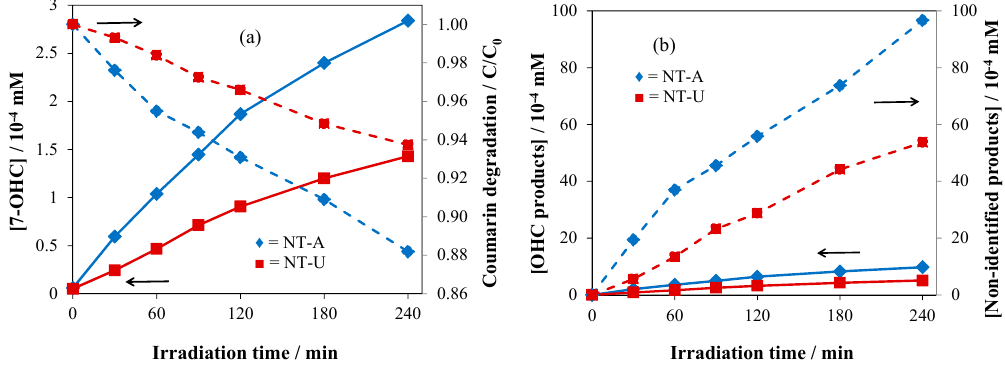
Figure 9. ( a ) 7-OHC formation vs. coumarin degradation and ( b ) formation of OHC vs. non-identified products.